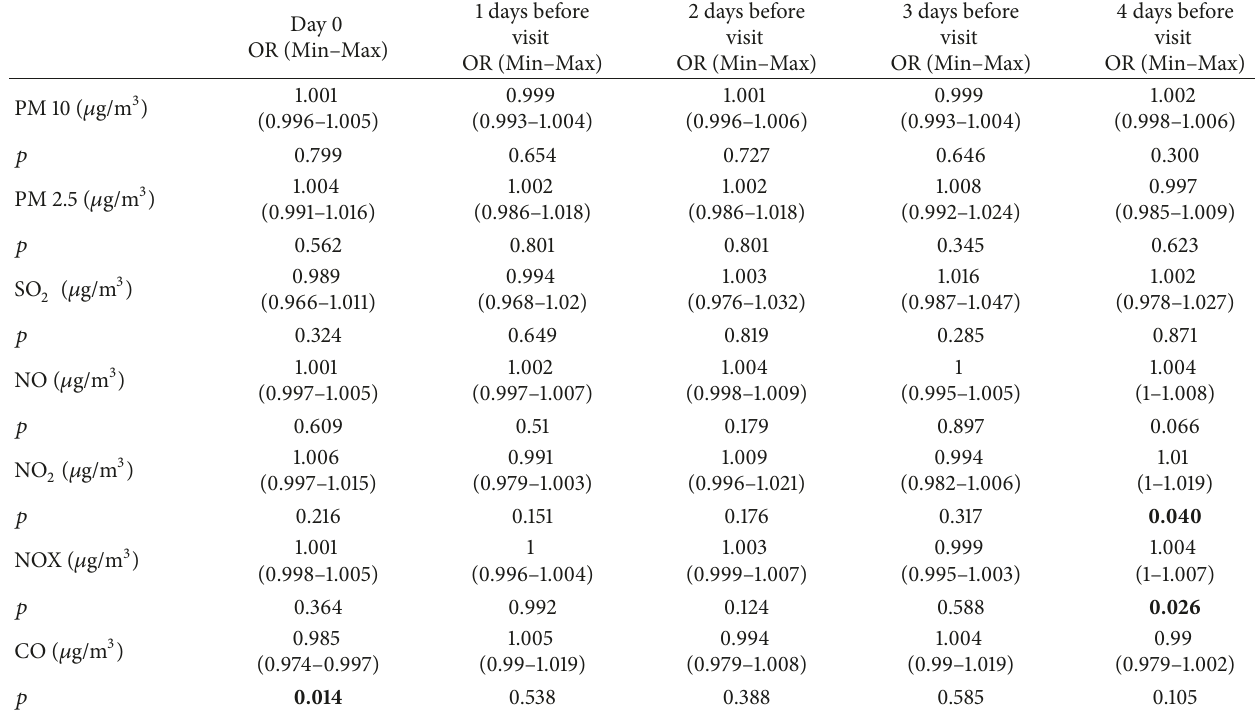
Table 10: Air pollution parameters for 4 days before visit due to